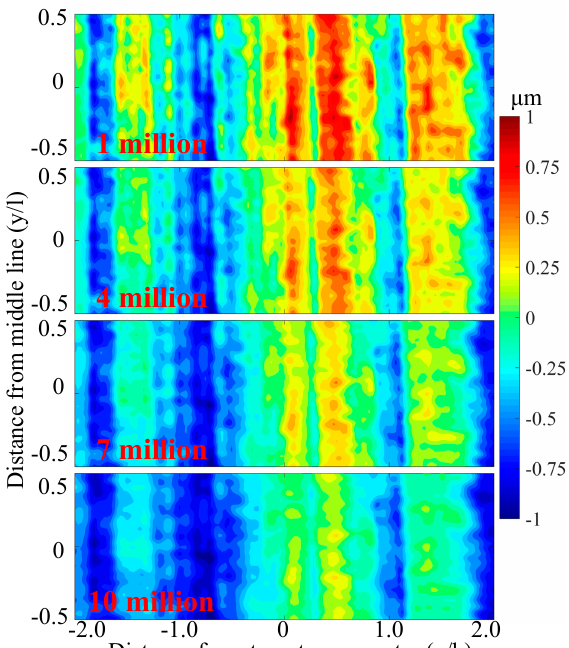
Figure 10. Surface evolution due to wear process.